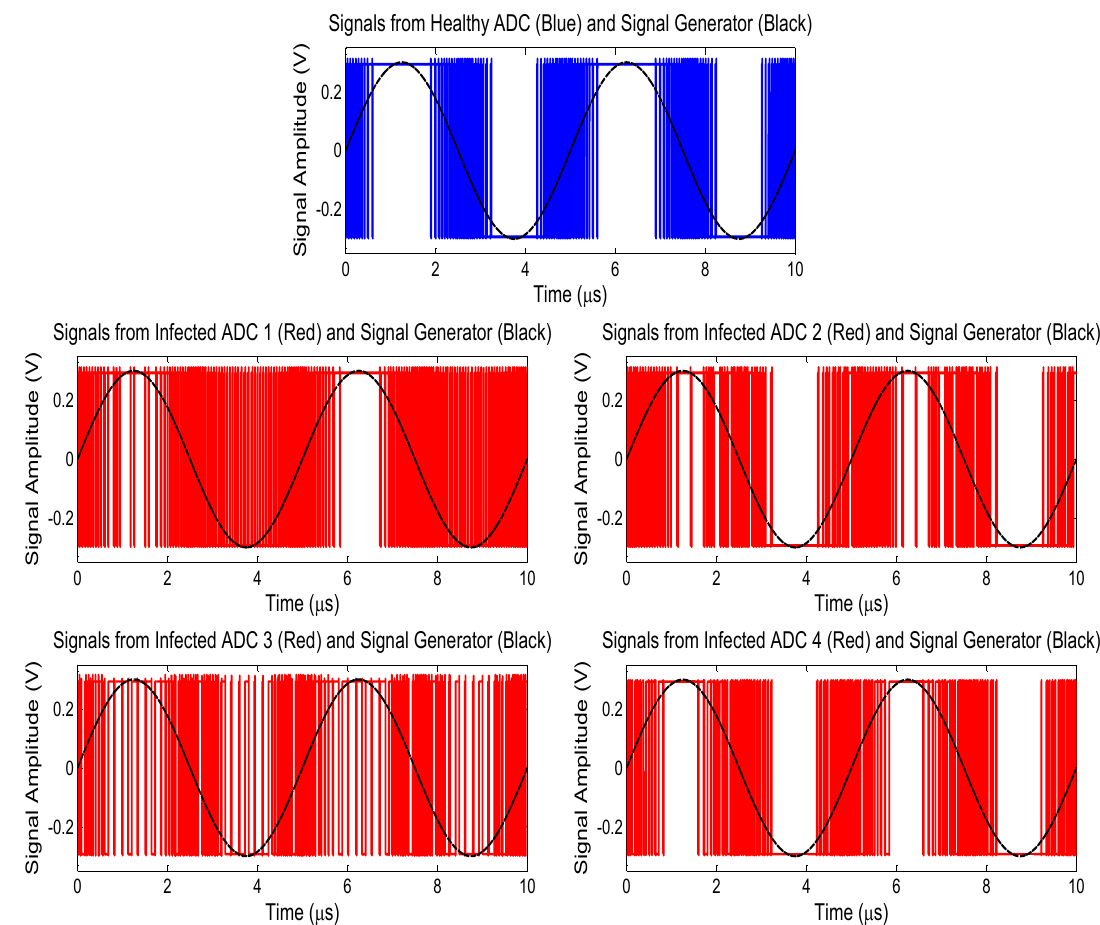
Figure 9. Analysis of Attacks: The delta-sigma modulator output signal in the “A” to “E” circuit